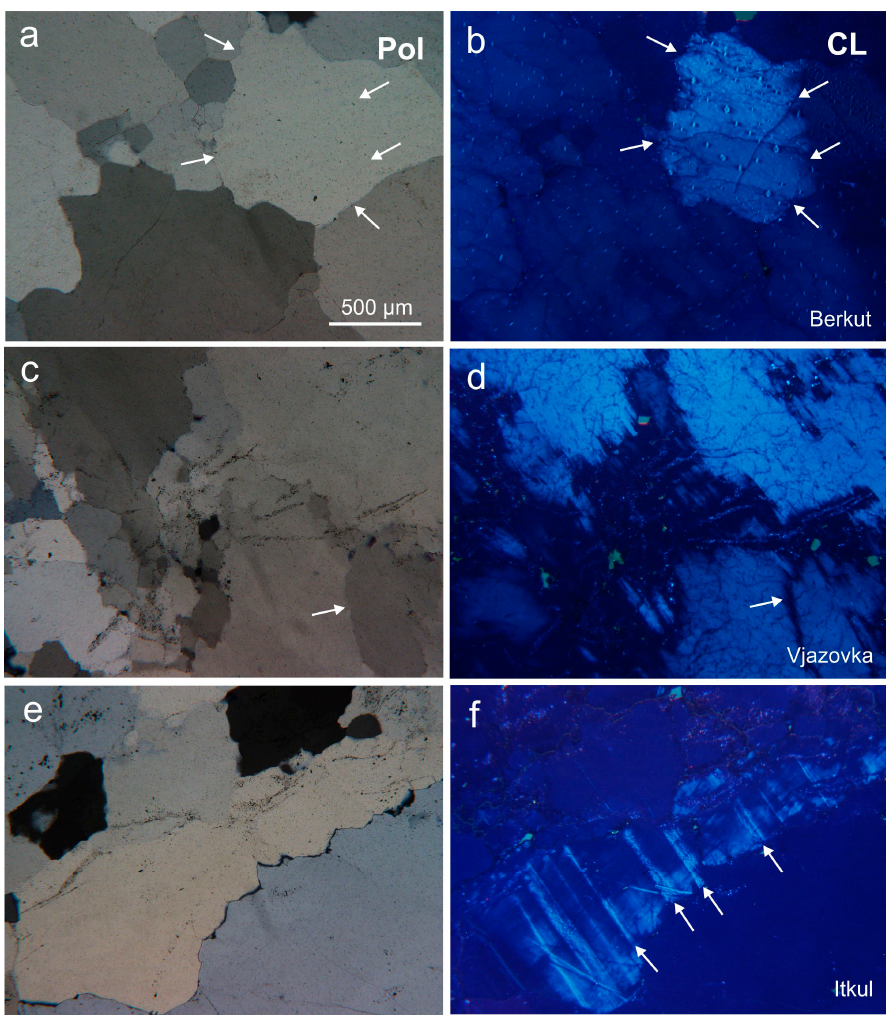
Figure 3. Examples of micro-structural heterogeneities detected by cathodoluminescence (CL) in the investigated quartz samples mostly invisible in transmitted light (crossed polars—Pol): ( a , b ) brightly luminescing sub-grain areas in the pegmatite quartz from Berkutinskaya (Berkut); ( c , d ) trails of reduced CL intensity (arrow) due to migration of fluids in the hydrothermal quartz from Vjazovka (Vja); ( e , f ) dislocation planes in the hydrothermal quartz from Itkulskoe (Itkul). Pegmatite quartz shows a more or less homogeneous bluish-green CL with a characteristic CL emission band at ca. 500 nm (Figure 4a). Sub-grain areas with strong CL (Figure 3b) have the highest intensities of this 500 nm band indicating the highest amounts of the luminescence related defect(s). The intensity of the 500 nm emission strongly decreases under electron irradiation. The resulting CL spectrum after 5 min of electron bombardment consists of an emission band at 450 nm and a weak band at 650 nm (Figure 4a).